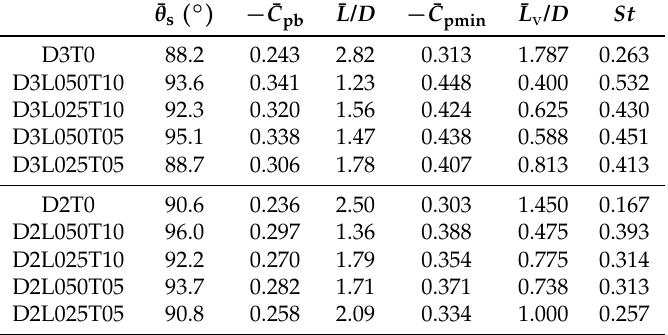
Table 5. Comparison of statistical flow parameters for the simulated water drops falling in stagnant air and turbulent surroundings, e.g., the flow separation angle, base suction pressure, length of the wake recirculation, minimum pressure coefficient, vortex formation length and Strouhal numbers.